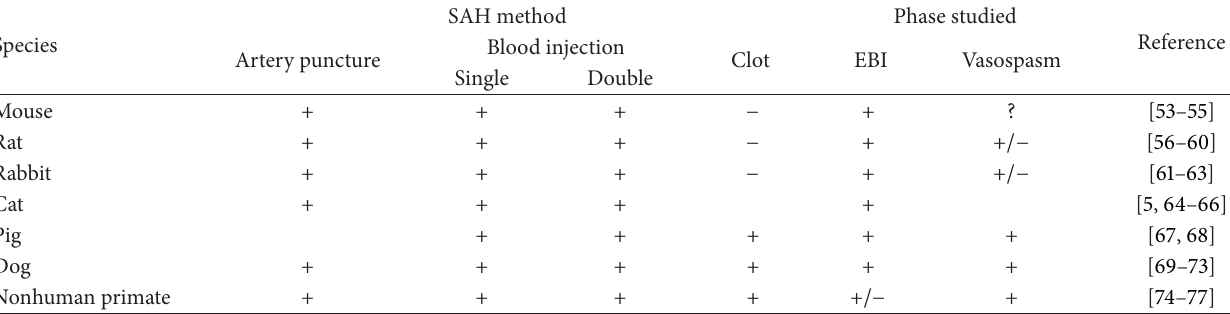
Table 2: Experimental models of aSAH and/or